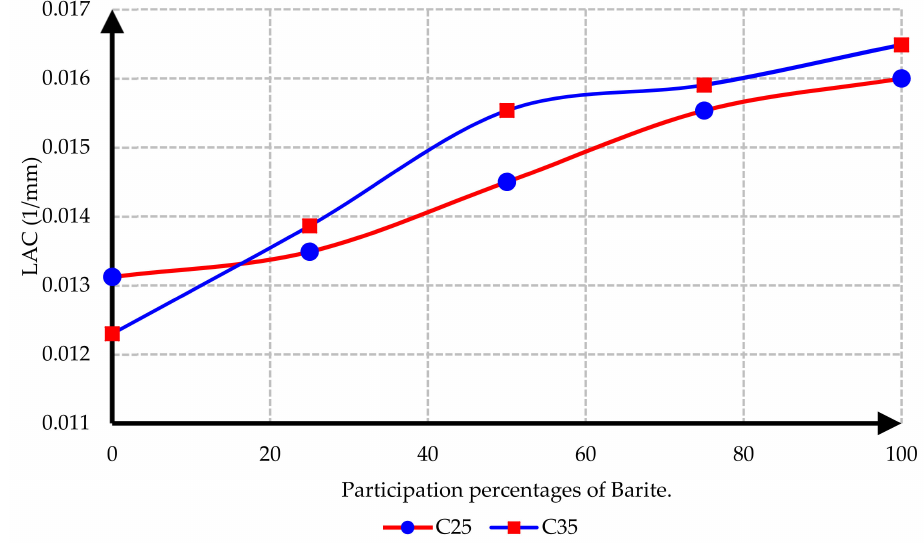
Figure 17. Comparison of LAC in concretes with different ratios of